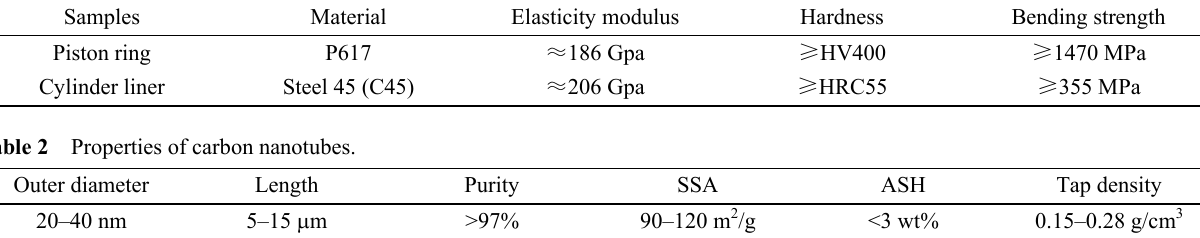
Fig. 2 Multi-functional tribometer. (a) Reciprocating tribometer test rig; (b) in-situ wear scar measurement and visualization system; (c) test control system; (d) online in-situ wear scar analysis. Table 1 Material properties of piston ring and cylinder liner.